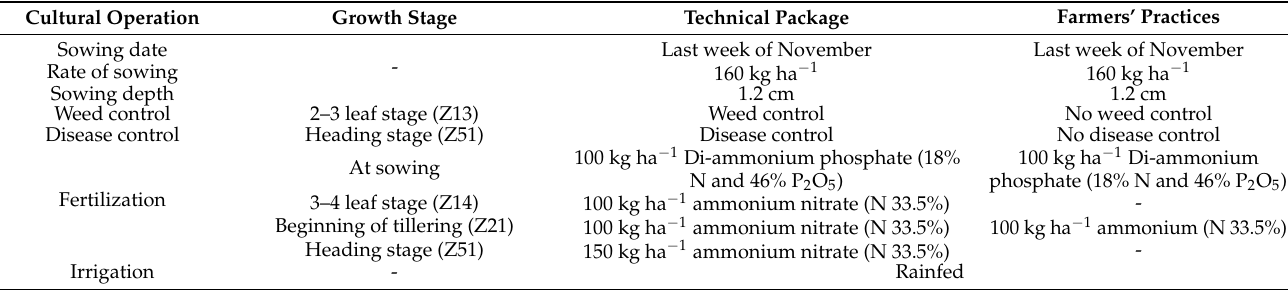
Table 1. Technical itineraries used in demonstration plots and farmers’ plots during 2013/14 and 2014/15 cropping seasons. Cultural